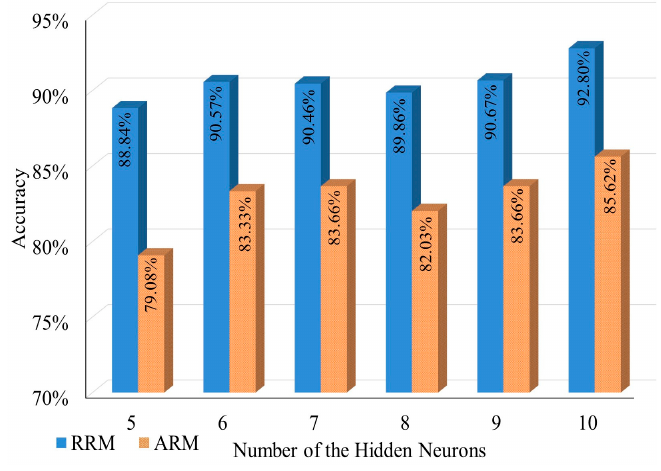
Figure 9. ANN positioning result accuracy.